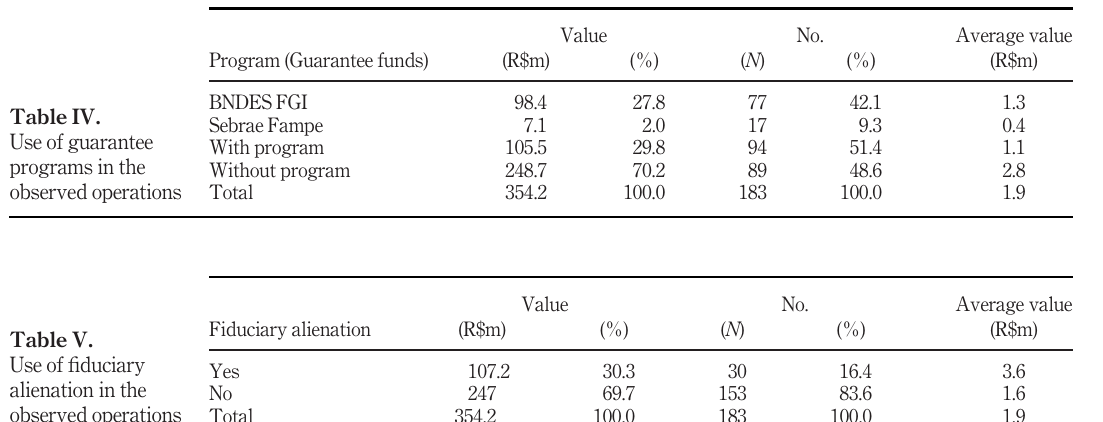
Table V. Use of fi duciary alienation in the observed operations